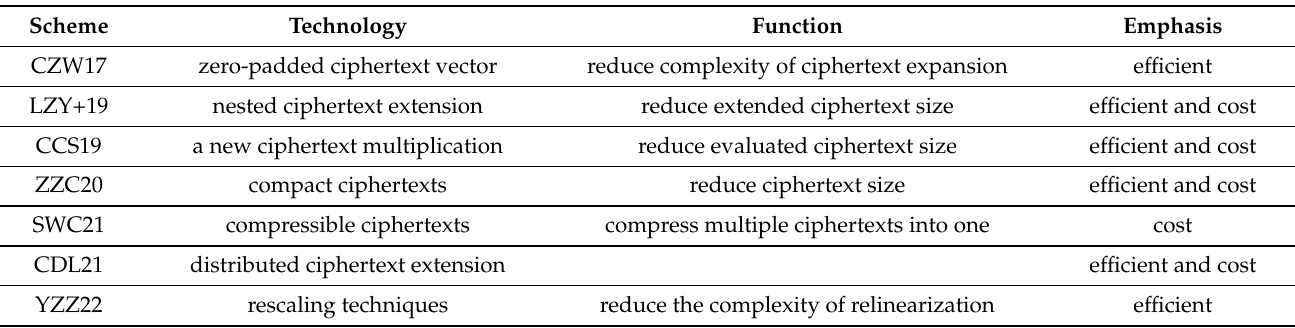
Table 4. Summary of Section